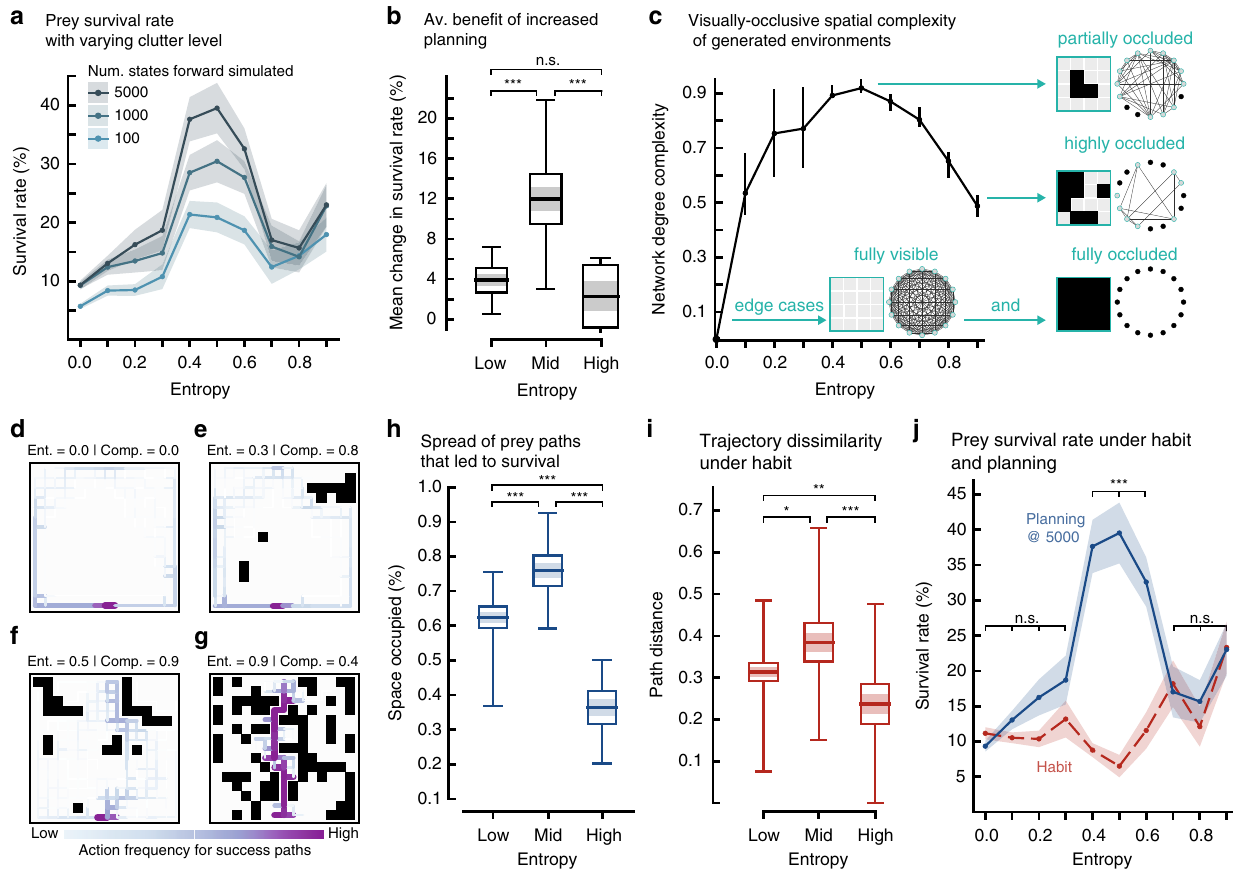
Fig. 3 The utility of different behavioral controllers in habitats with varying complexity. a Mean survival rate versus clutter density across random predator locations ( n = 5), for a given planning level. The fi ll indicates ±s.e.m. across randomly generated environments ( n = 20). b Mean change